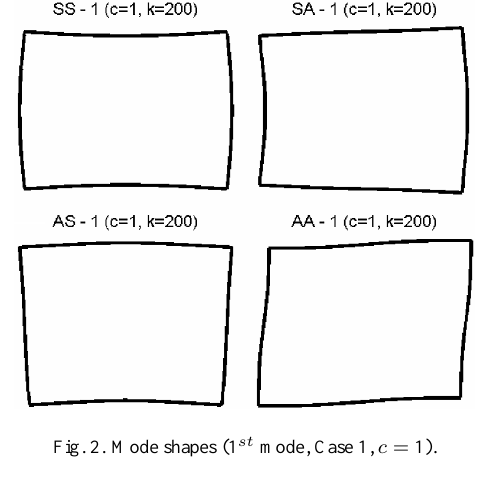
Fig. 2. Mode shapes (1 st mode, Case 1, c = 1).